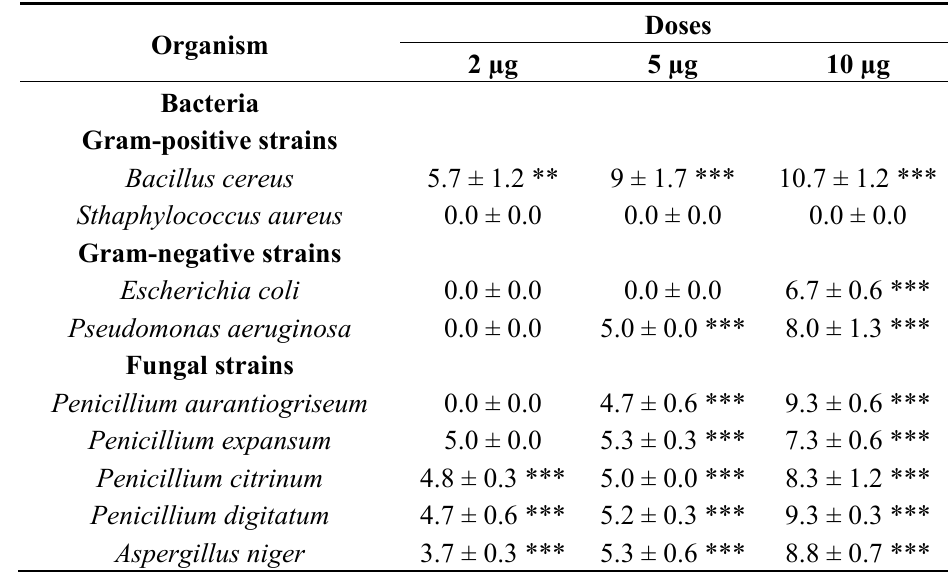
Table 2. Antimicrobial activity of the leaf essential oil of Moringa oleifera